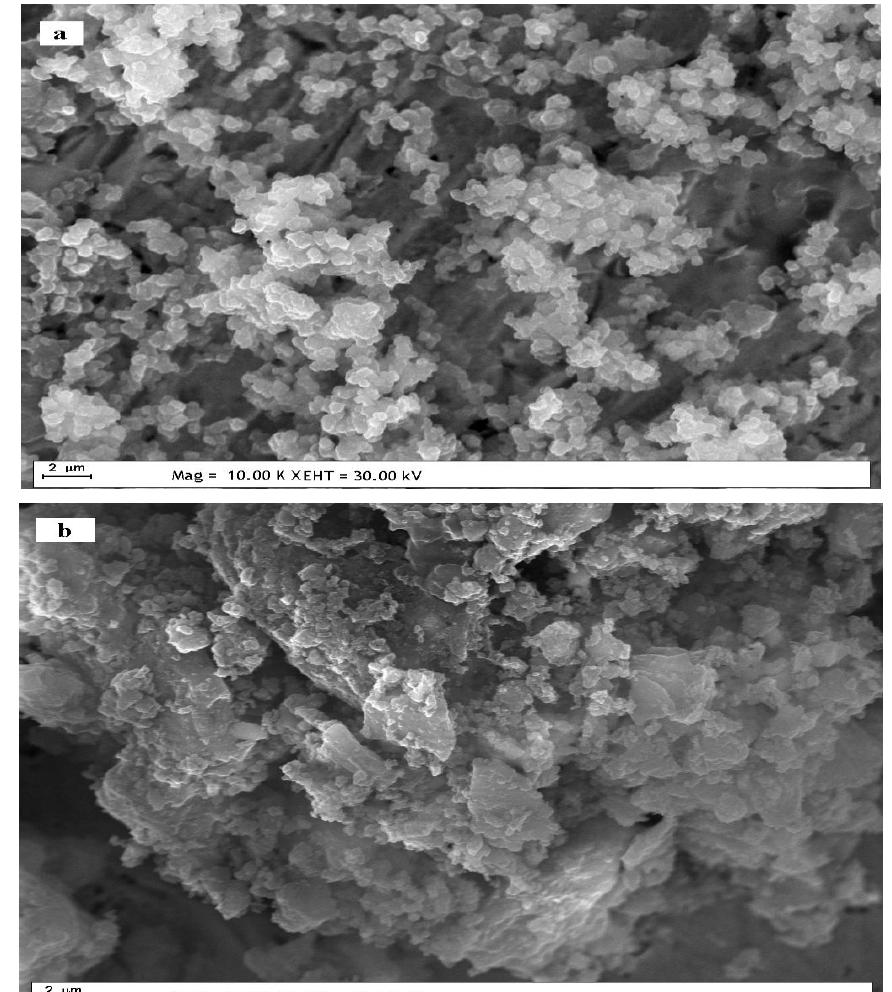
Figure 12. SEM images of ( a ) dsDNA immobilized UME-2 ( b ) ssDNA immobilized